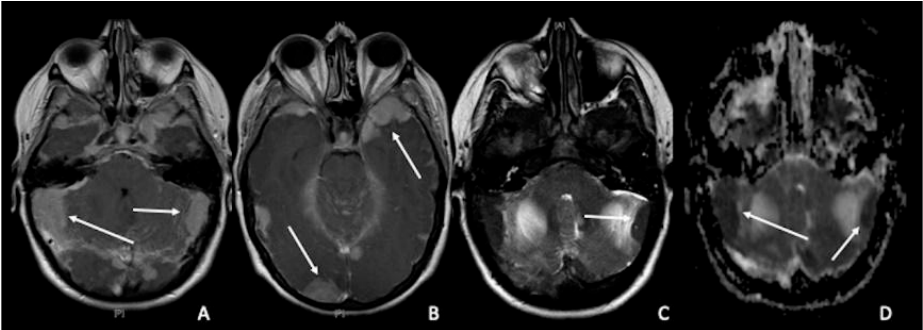
Figure 7. Multiple Chloromas (both supratentorial and infratentorial) in a patient with leukemia: ( A , B ) Pathologic extra-axial tissue enhancement after gadolinium (arrows) showed ( C , D ) restricted diffusion (arrows).